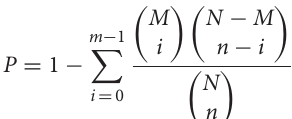
the Solexa Sequencing Chip (Flowcell) and consequently grown into single-molecule cluster sequencing templates through in situ amplification on the Illumina Cluster Station.